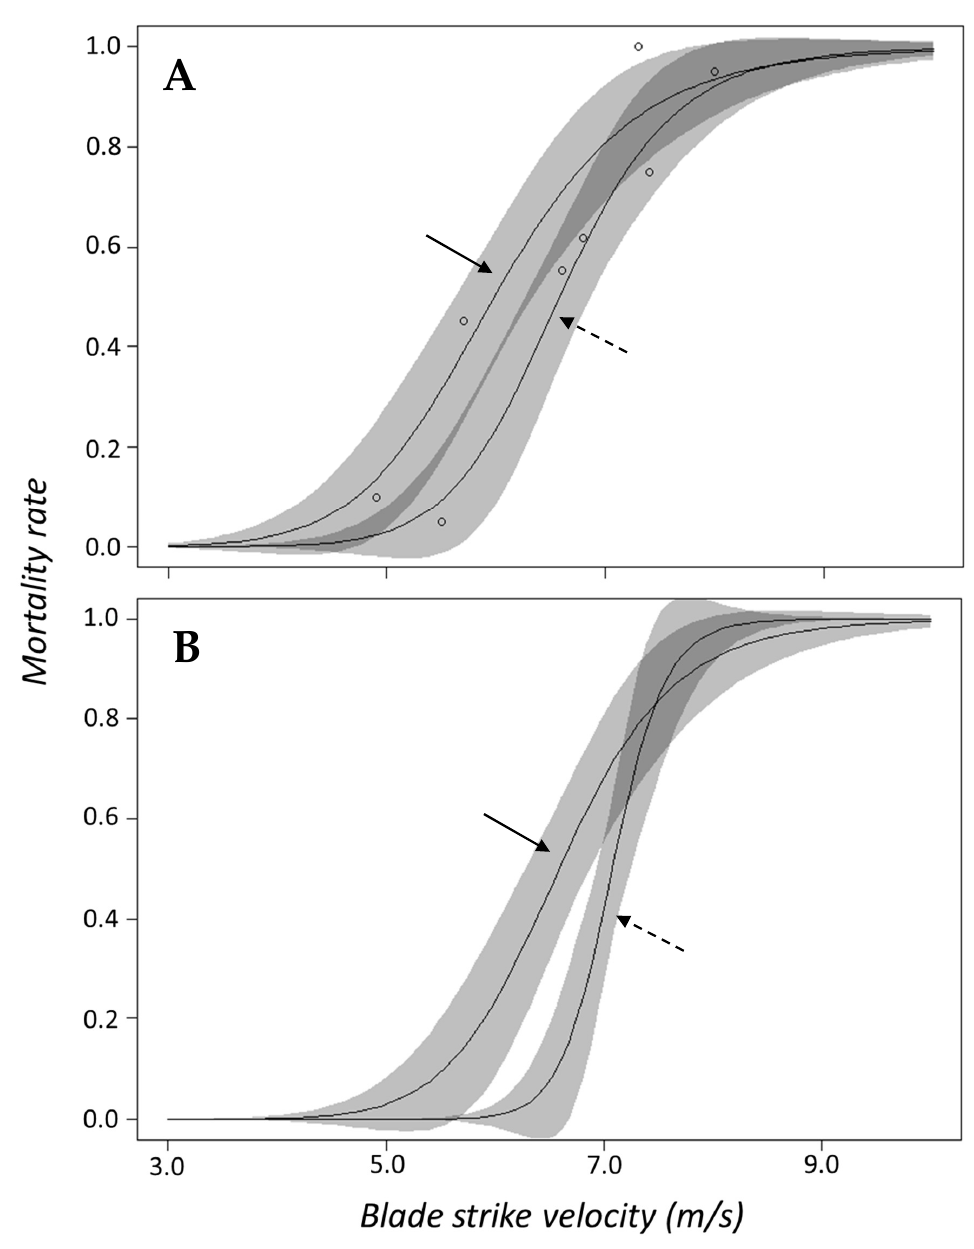
Figure 8. Plot of dose–response curves for ( A ) large rainbow (solid arrow) and brook (dashed arrow) trout and ( B ) small (dashed arrow) and large (solid arrow) rainbow trout which highlights the 95% confidence bands for each curve.